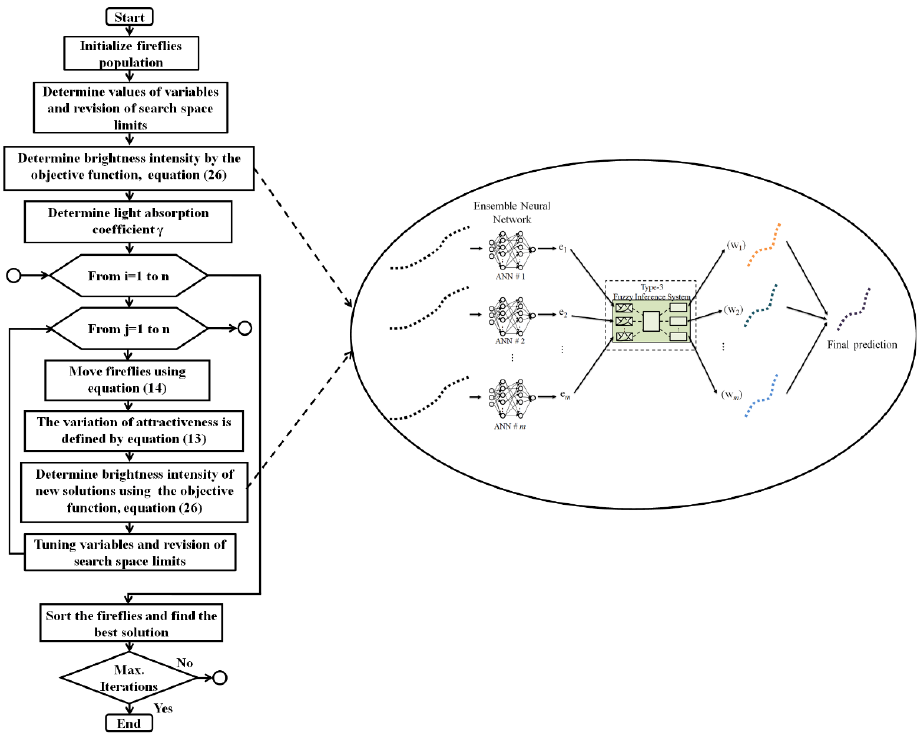
Figure 8. Flowchart of the FA.